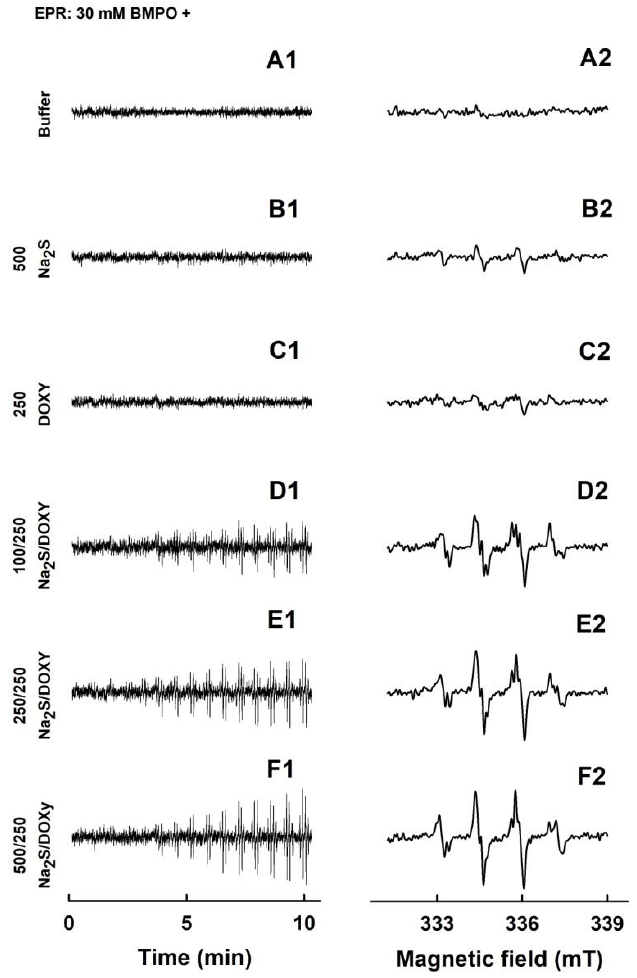
Figure 4. EPR spectra of the • BMPO adducts for Na 2 S and DOXY and their mutual combinations.